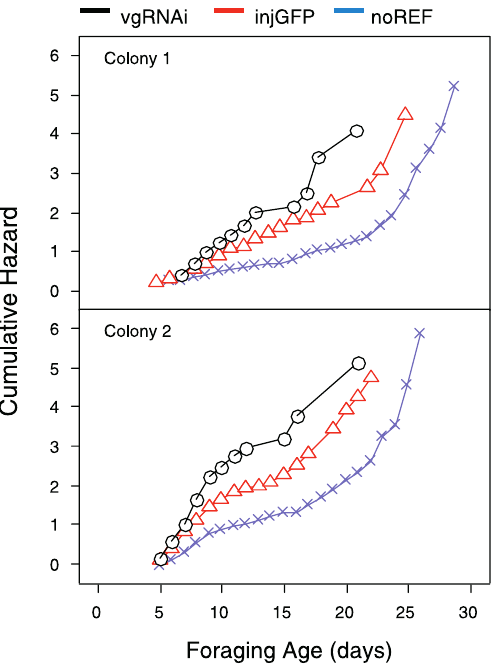
Figure 2. Effect of vitellogenin Gene Activity on Age at Foraging Onset Cumulative hazard increases until all bees have foraged. Knockdowns (vgRNAi) initiated foraging behavior earlier in life than injected controls (injGFP; LRT ¼ 8.81, df ¼ 1, p , 0.003, hazard ratio [comparative risk of initiating foraging calculated over the entire time of the study] ¼ 1.43 d